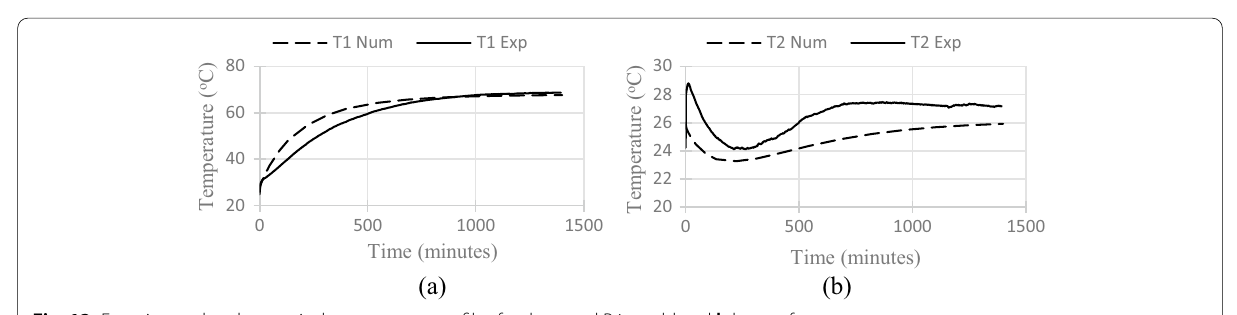
Fig. 12 Experimental and numerical temperature profiles for the panel P4 a cold and b hot